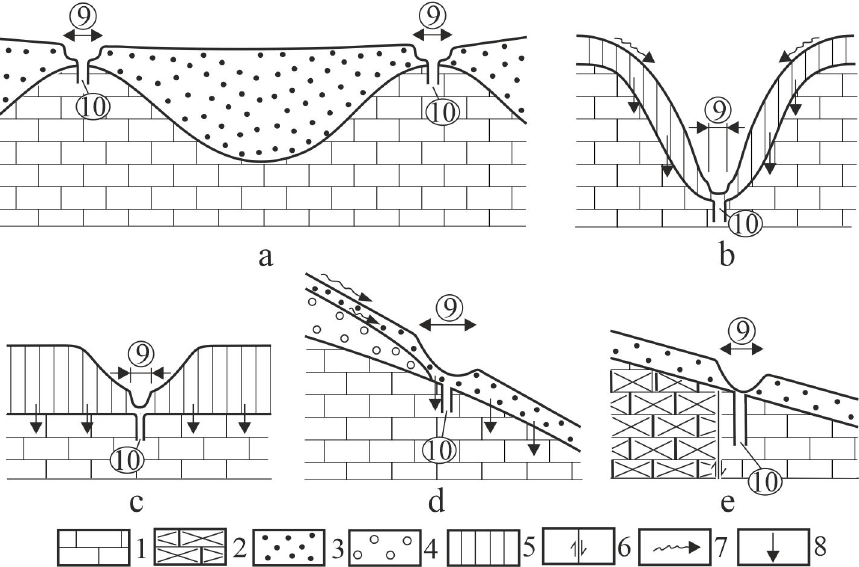
Figure 7. Development of subsidence dolines [33]. Legend: Development of subsidence dolines at various development environments: ( a ) above the mound of the bedrock at low accumulation cover thickness, ( b , c ) at cover that thinned out in an erosional way, ( d ) at the termination of covered impermeable cover, ( e ) at the margin of covered, intercalated non-karstic rock, 1. limestone, 2. non- karstic rock, 3. permeable cover, 4. impermeable cover, 5. reworked, partly impermeable cover, 6. fault, 7. water flow, 8. infiltration, 9. subsidence doline, 10. shaft.